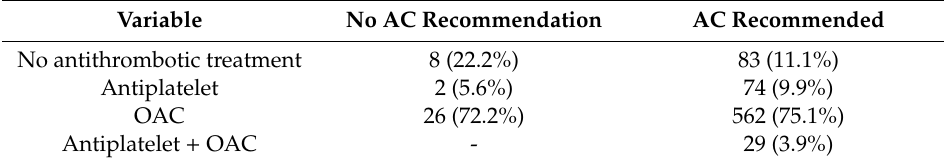
Table 2. OAC and / or antiplatelet treatment according to the risk of stroke.